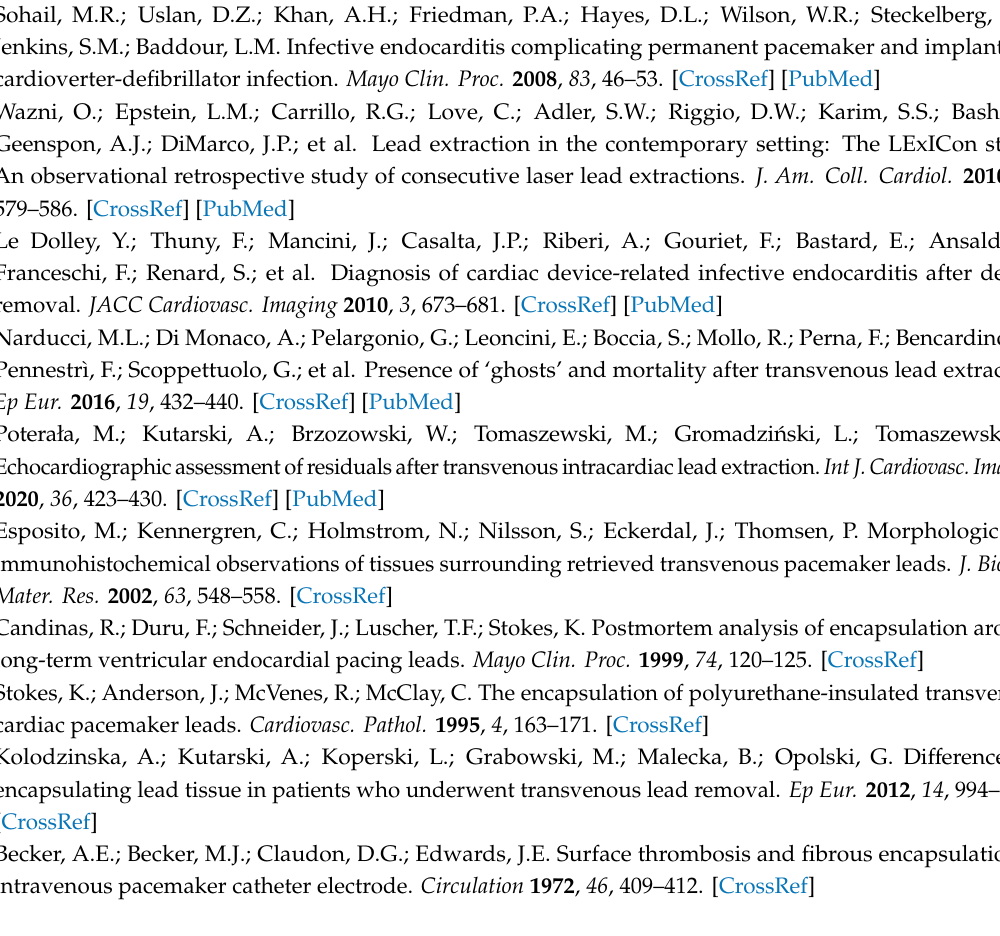
Figure S1: Intra and inter observer variability of lead thickness measurement. The limits of agreement are narrow for both the intra and inter-observer graph (within 1 mm) yielding a coe ffi cient of repeatability from duplicate measurement at 0.74 mm and 0.77 mm, respectively, Video S1: Linked to Figure 1. See Figure 1 for explanation, Video S2: Linked to Figure 3. See Figure 3 for explanation, Video S3: Linked to Figure 5. See Figure 5 for